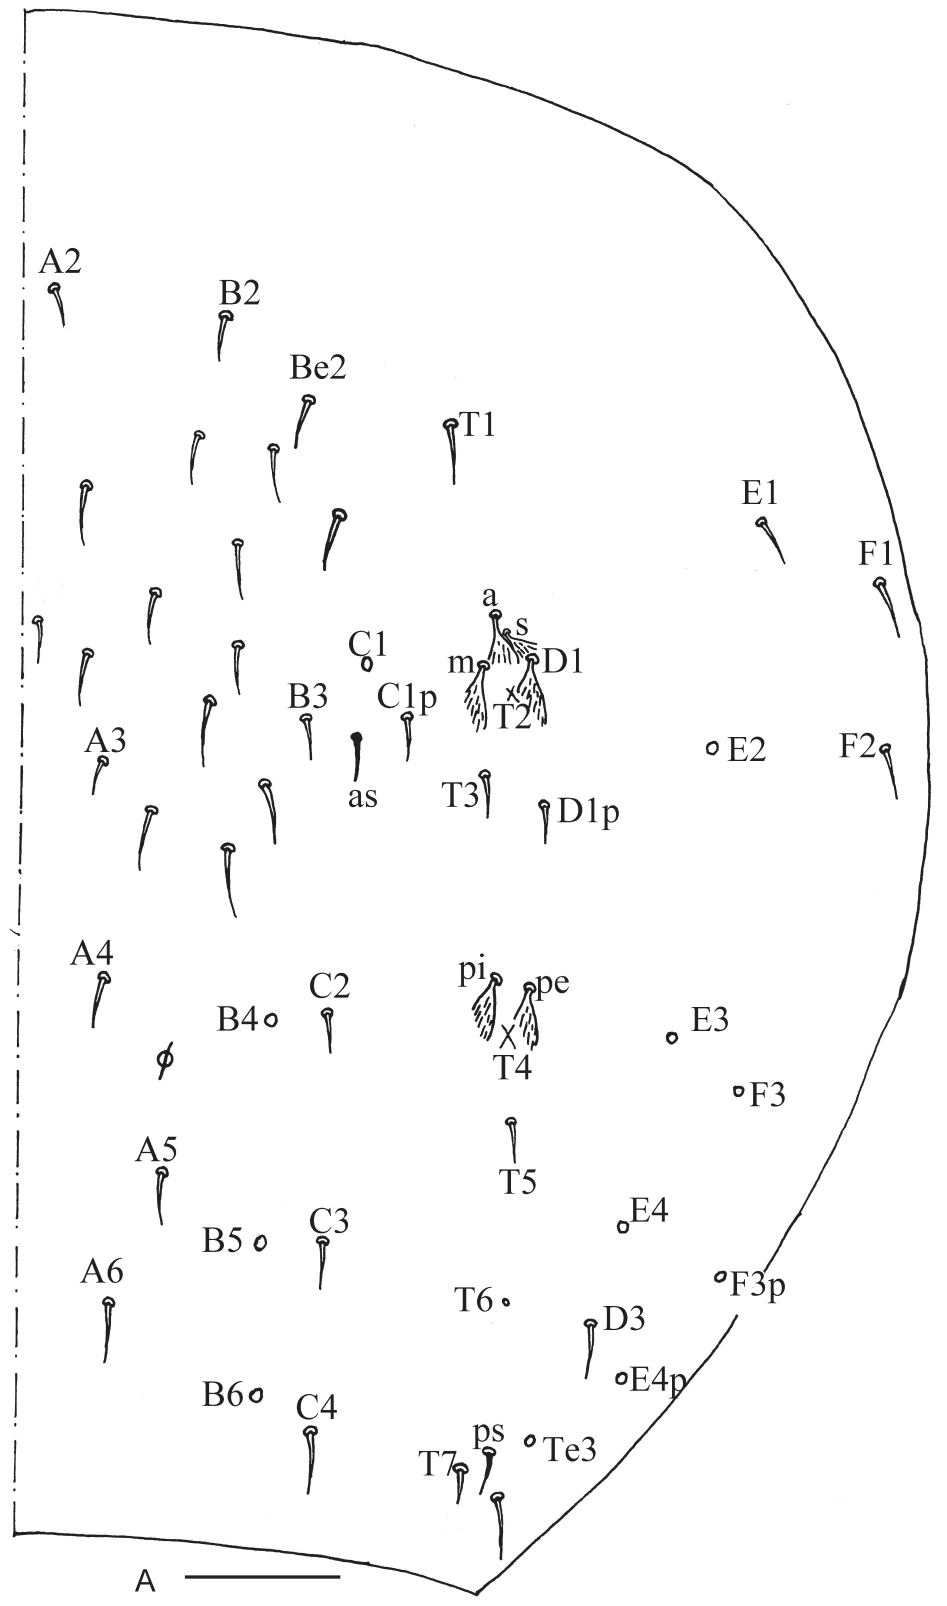
Fig. 15. Lepidocyrtus (S.) wanningensis sp. nov., chaetotaxy of Abd. IV (right side). Scale bar: 60